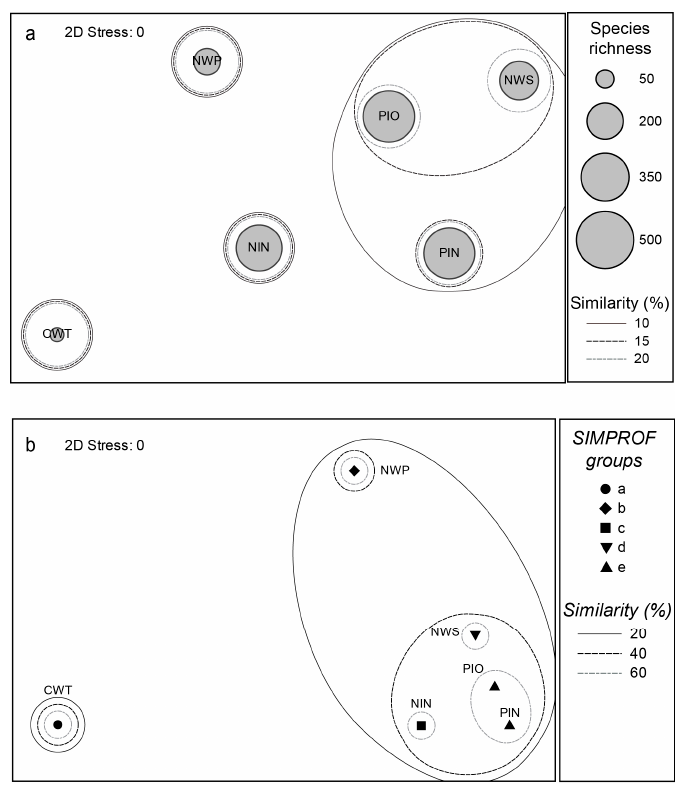
Figure 6. Multi-dimensional scaling (MDS) ordination of the Jaccard similarity matrix for sponge communities within the Pilbara region at the ( a ) species level with bubble plots representing species richness at each bioregion and ( b ) at the genus level with cluster groupings based on SIMPROF analysis shown. Final stress of configuration = 0 at the two taxonomic levels investigated. PIN–Pilbara Nearshore, PIO–Pilbara Offshore, NIN–Ningaloo, NWS–Northwest Shelf, NWP–Northwest Province and CWT–Central West Transition.